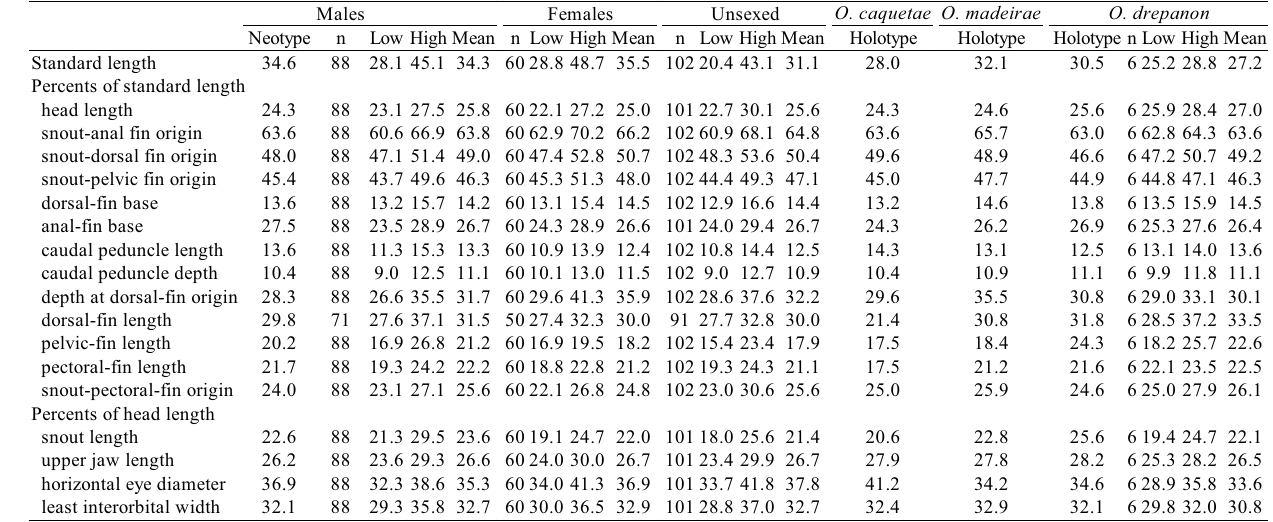
Table 1. Morphometrics of Odontostilbe fugitiva , upper rio Amazonas basin (río Ucayali, río Marañon, río Putumayo, río Itaya, río Mazán, río Ampyiacu, río Amazonas, río Yavari, rio Juruá, rio Madeira, rio Solimões). Neotype MUSM 27501 of río Mazán, affluent of mouth of río Napo. Separately, the holotype ANSP 70495 of Odontostilbe caquetae syn. from the río Caquetá basin, the holotype ANSP 39193 of O. madeirae syn., and holotype ANSP 39210 of O. drepanon syn., plus six paratypes ANSP 39211 from the rio Madeira